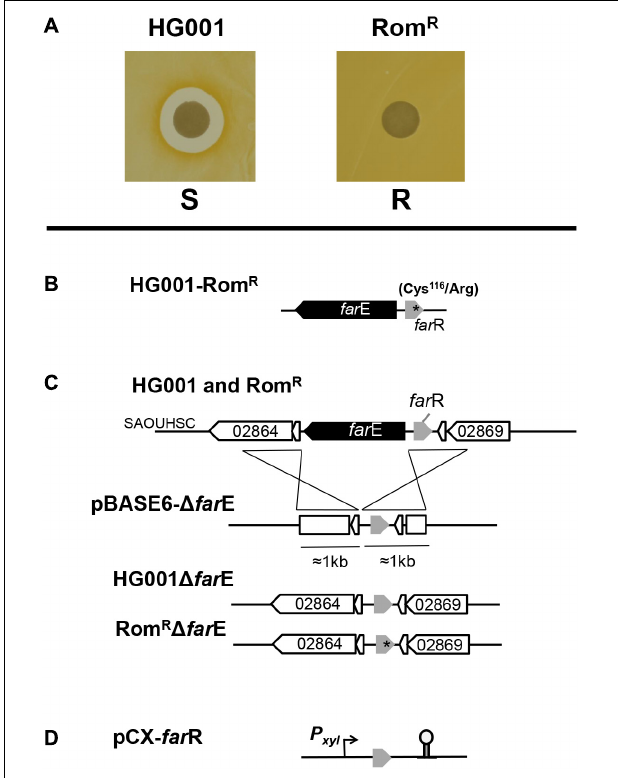
FIGURE 1 | Rom-resistance phenotype, genetic analysis and construction of deletion mutants and clones. (A) The Rom R clone shows no inhibition halo in the agar diffusion method with 100 µ g Rom loaded on the filter disks. (B) Genetic organization of the divers oriented farR and farE genes and location of the single point mutation ( ∗ ) in farR leading to an amino acid exchange (Cys116/Arg) in the FarR regulator protein in the Rom R clone. (C) Illustration of farE deletion construction in HG001 and the Rom R clone. For homologous double-cross recombination, pBASE6- (cid:49) farE containing approximately 1 kb upstream and downstream DNA sequences were used; (cid:49) farE positive clones were controlled by PCR and sequencing. (D) pCX30:: farR is the farR complementation plasmid in which the transcription of the gene is